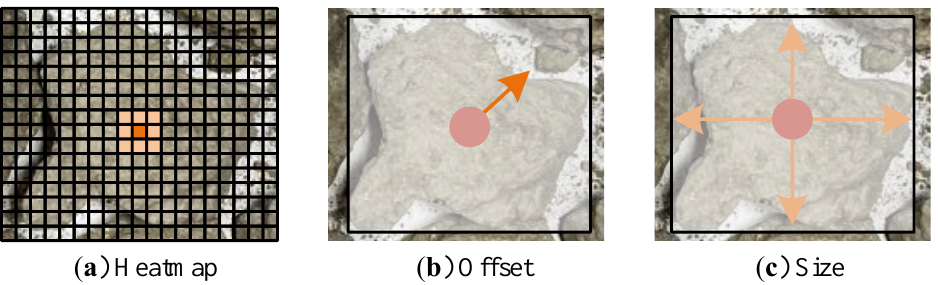
Figure 5. Illustration of output of the three branches of the proposed algorithm. ( a ) The location of the center point of the heatmap branch output. ( b ) Offset branches are used to predict the centroid position offset. ( c ) The size branch is used to predict the target width and